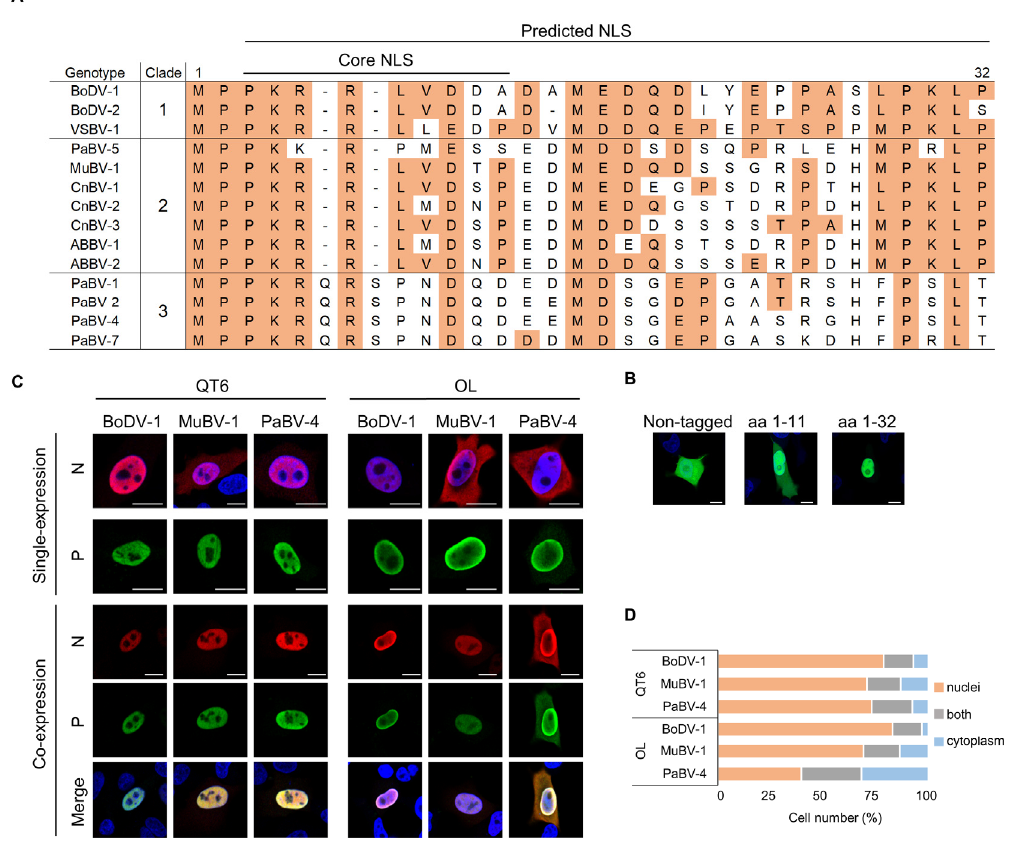
Figure 4. Comparison of the nuclear localization activity of orthobornavirus N proteins. ( A ) Alignment of NLS sequences of N proteins among orthobornavirus genotypes. The nuclear localization signal (NLS) regions (aa 1-32) predicted by cNLS Mapper were aligned. The residues identical to those of BoDV-1 are shown in yellow boxes. ( B ) Nuclear localization activity of BoDV-1 N-NLS. Human oligodendroglioma (OL) cells were transfected with plasmids encoding BoDV-1 N-NLS (aa 1-11 or 1-32)-fused tandem GFP, and GFP fluorescence was observed at 48 h post transfection. Bars, 10 µ m. ( C ) Subcellular localization of the N and P proteins of BoDV-1, MuBV-1 and PaBV-4 in avian and mammalian cells. Myc-tagged N and FLAG-tagged P expression plasmids were transfected into QT6 and OL cells alone or together. The subcellular localization of N and P was detected by immunostaining 48 h after transfection. Representative images of transfected cells are shown. Bars, 10 µ m. ( D ) Subcellular localization of N in avian and mammalian cells co-transfected with N and P expression plasmids. QT6 and OL cells were transfected with plasmids expressing the N protein and FLAG-tagged P protein from BoDV-1 (clade 1), MuBV-4 (clade 2) and PaBV-4 (clade 3). The subcellular localization of N proteins was analyzed by fluorescence immunostaining at 48 h post transfection by confocal microscopy. N protein localization (nuclear, cytoplasmic, or both) was assessed (200 cells, n = 3), and the percentage was